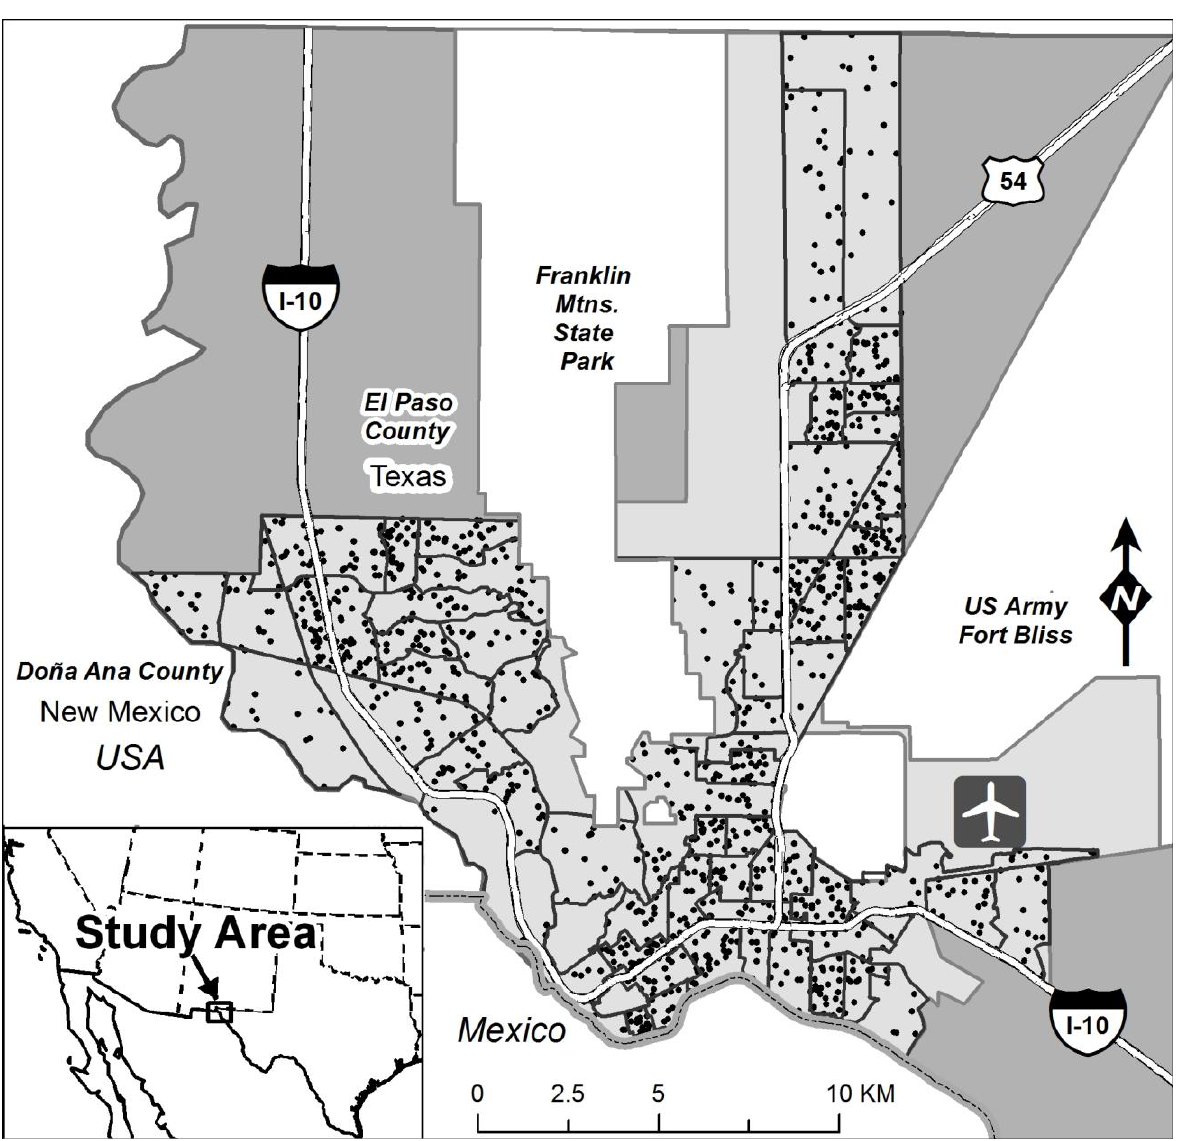
Figure 1. Approximate home locations of Hispanic children (black points) in census tracts (black bordered polygons) within the EPISD (light